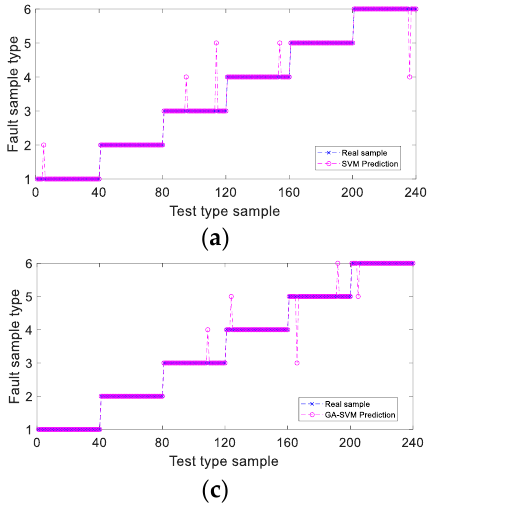
Figure 10. Classification results of four classifiers for combine harvester failures. ( a ) SVM diagnostic result, ( b ) PSO-SVM diagnostic result, ( c ) GA-SVM diagnostic result, and ( d ) IPSO-SVM diagnostic result. Table 4. The fault identification results of the IPSO-SVM model on the test set